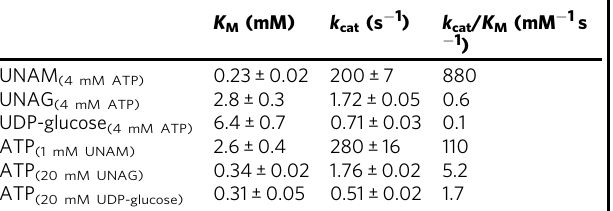
Table 2 Michaelis-Menten parameters of ng ζ _1 activity